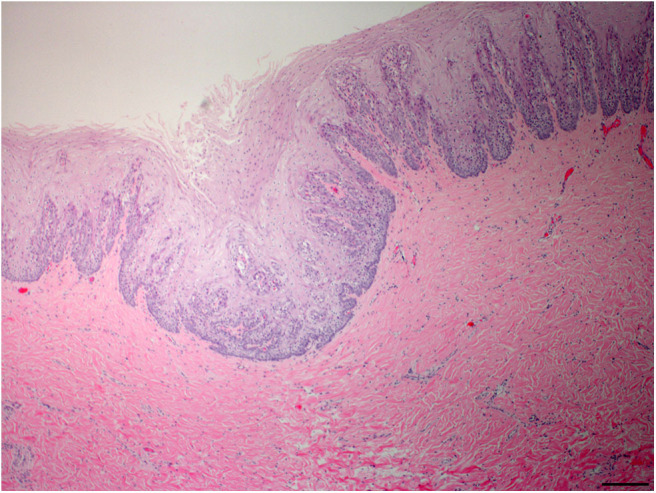
Oropharyngeal mucosal plaque, rough-toothed dolphin (case R305). Submucosa, focal invagination of hyperplastic epithelium with moderate retention of stratum externum layer, and thickening of the stratum intermedium with epithelial peg disorganization and fusion (HE) Obj. 4x. Bar = 200 μm.